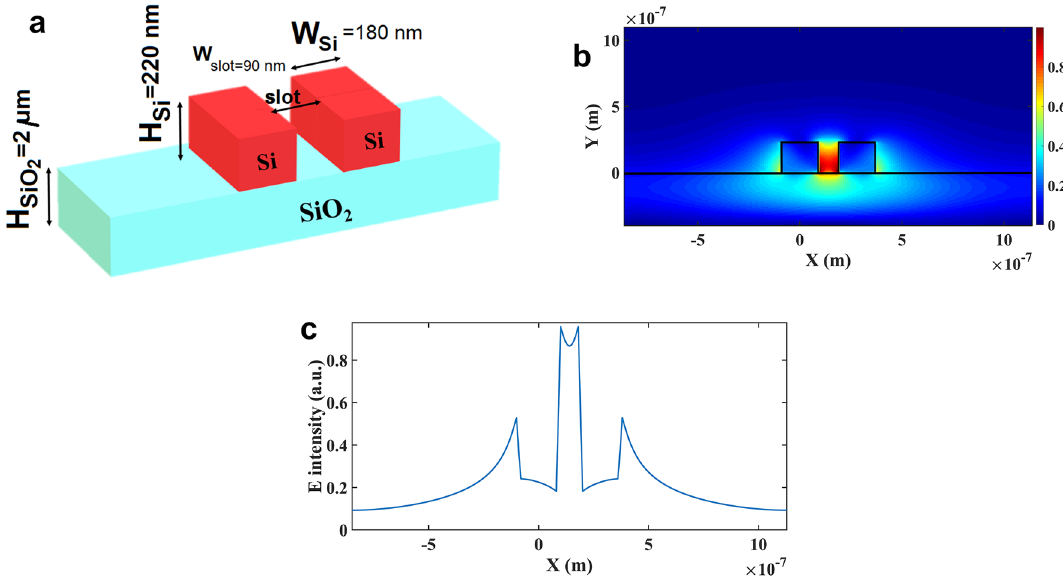
Figure 1. ( a ) The layout of SOI slot bus-waveguide ( b ) the TE mode profiles of the single slot bus-waveguide, ( c ) the distribution of electric field intensity via the single slot